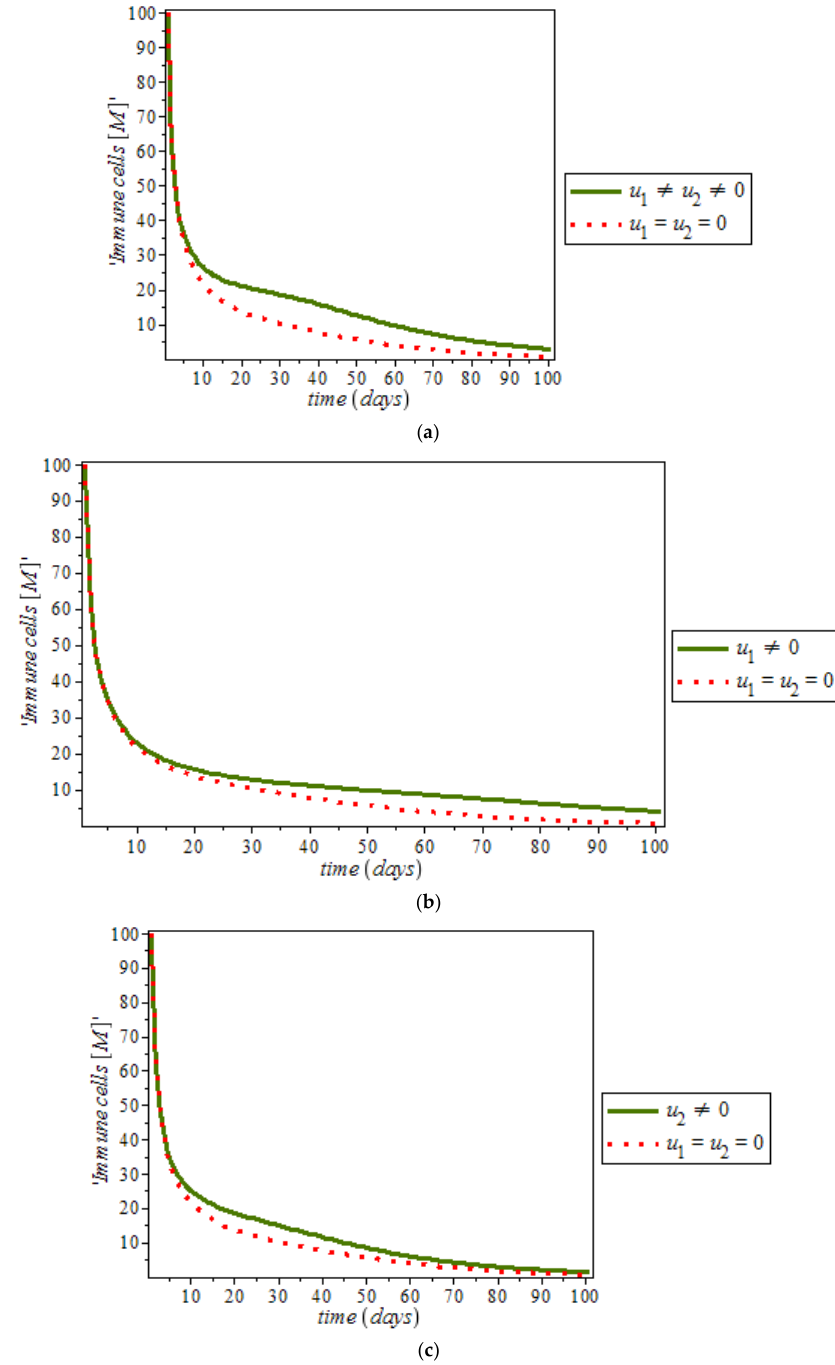
Figure 13. Simulation result of the model (9), showing immune response against time with and without